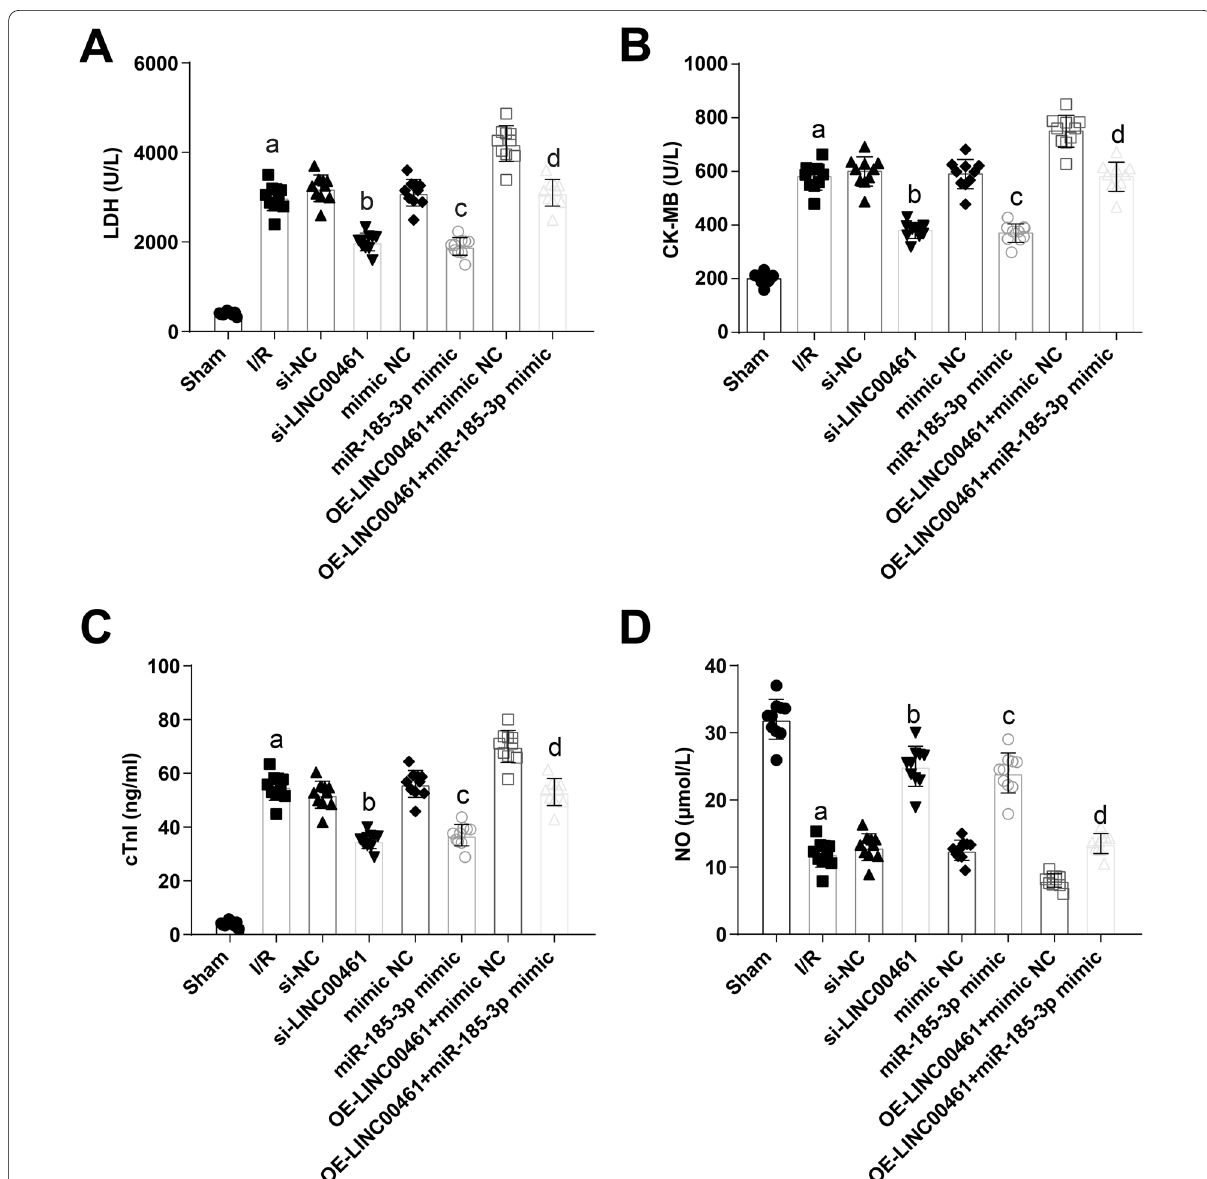
Fig. 6 Up-regulating miR-185-3p or down-regulating LINC00461 decreases LDH, CK-MB and cTn Ӏ contents as well as increases NO content in I/R mice. A Content of LDH in serum of abdominal aorta of mice in each group. B Content of CK-MB in serum of abdominal aorta of mice in each group. C Content of cTn Ӏ in serum of abdominal aorta of mice in each group. D Content of NO in serum of abdominal aorta of mice in each group. a P < 0.05 vs. the sham group. b P < 0.05 vs. the si-NC group. c P < 0.05 vs. the mimic-NC group. d P < 0.05 vs. the